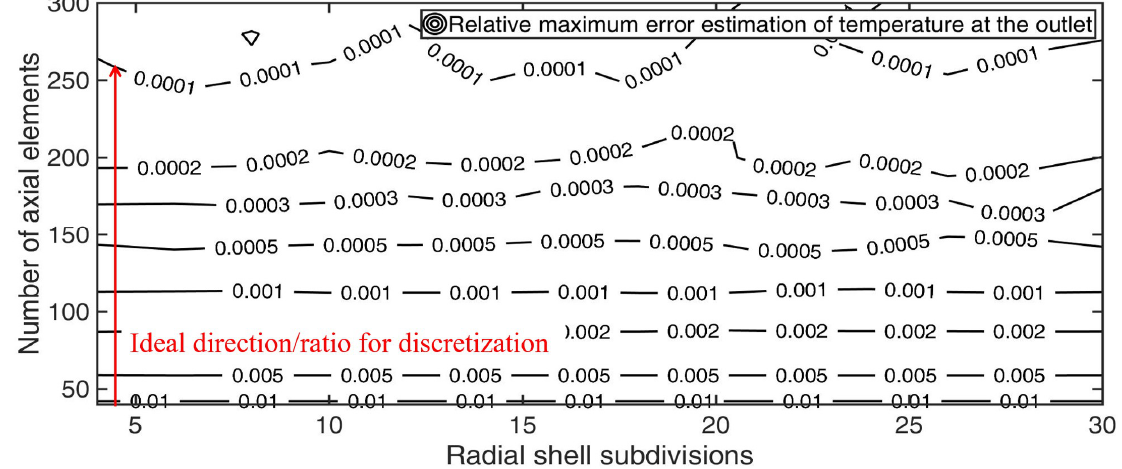
Figure 19. Estimations of maximal absolute errors at the outlet of the pipe (Case 2), where the red arrow signifies the ideal direction for discretization.